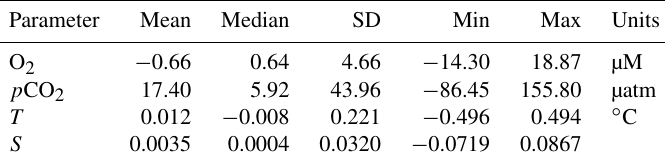
Table 3. SeaCycler–glider residuals.